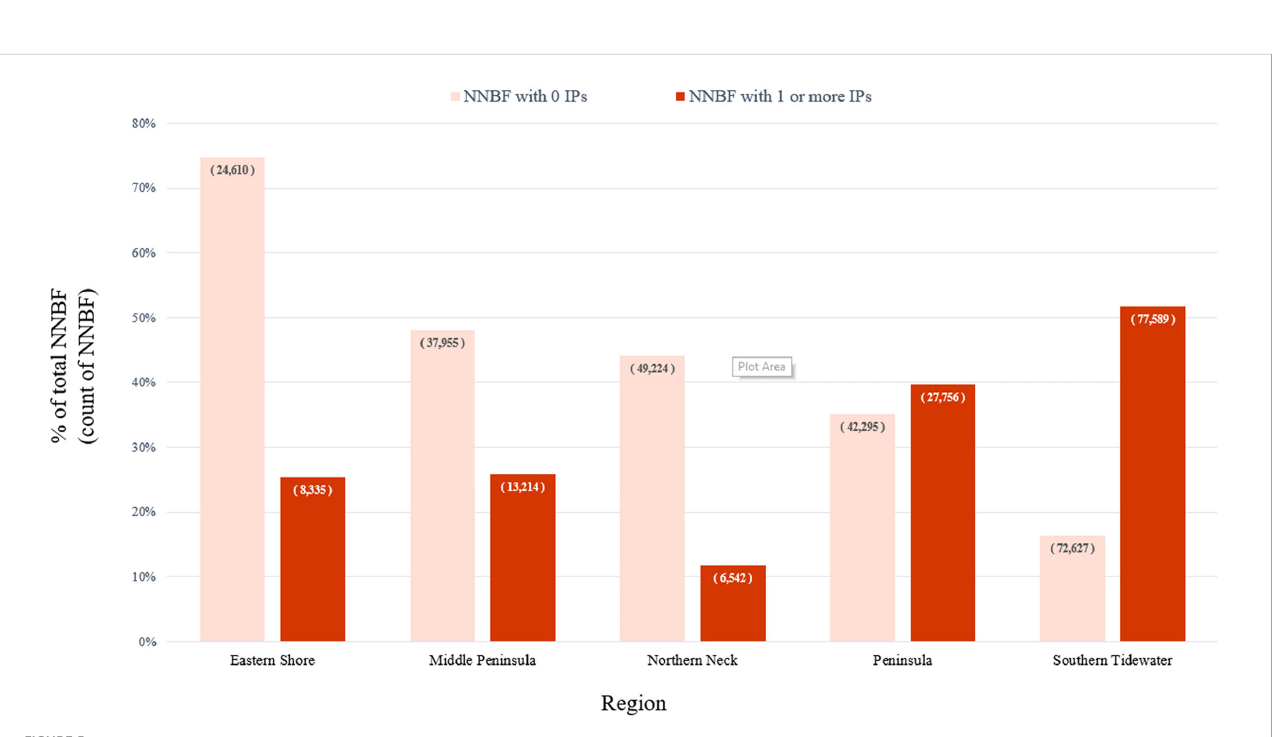
FIGURE 5 NNBF summarized by the number of IPs intersecting, per study area region.